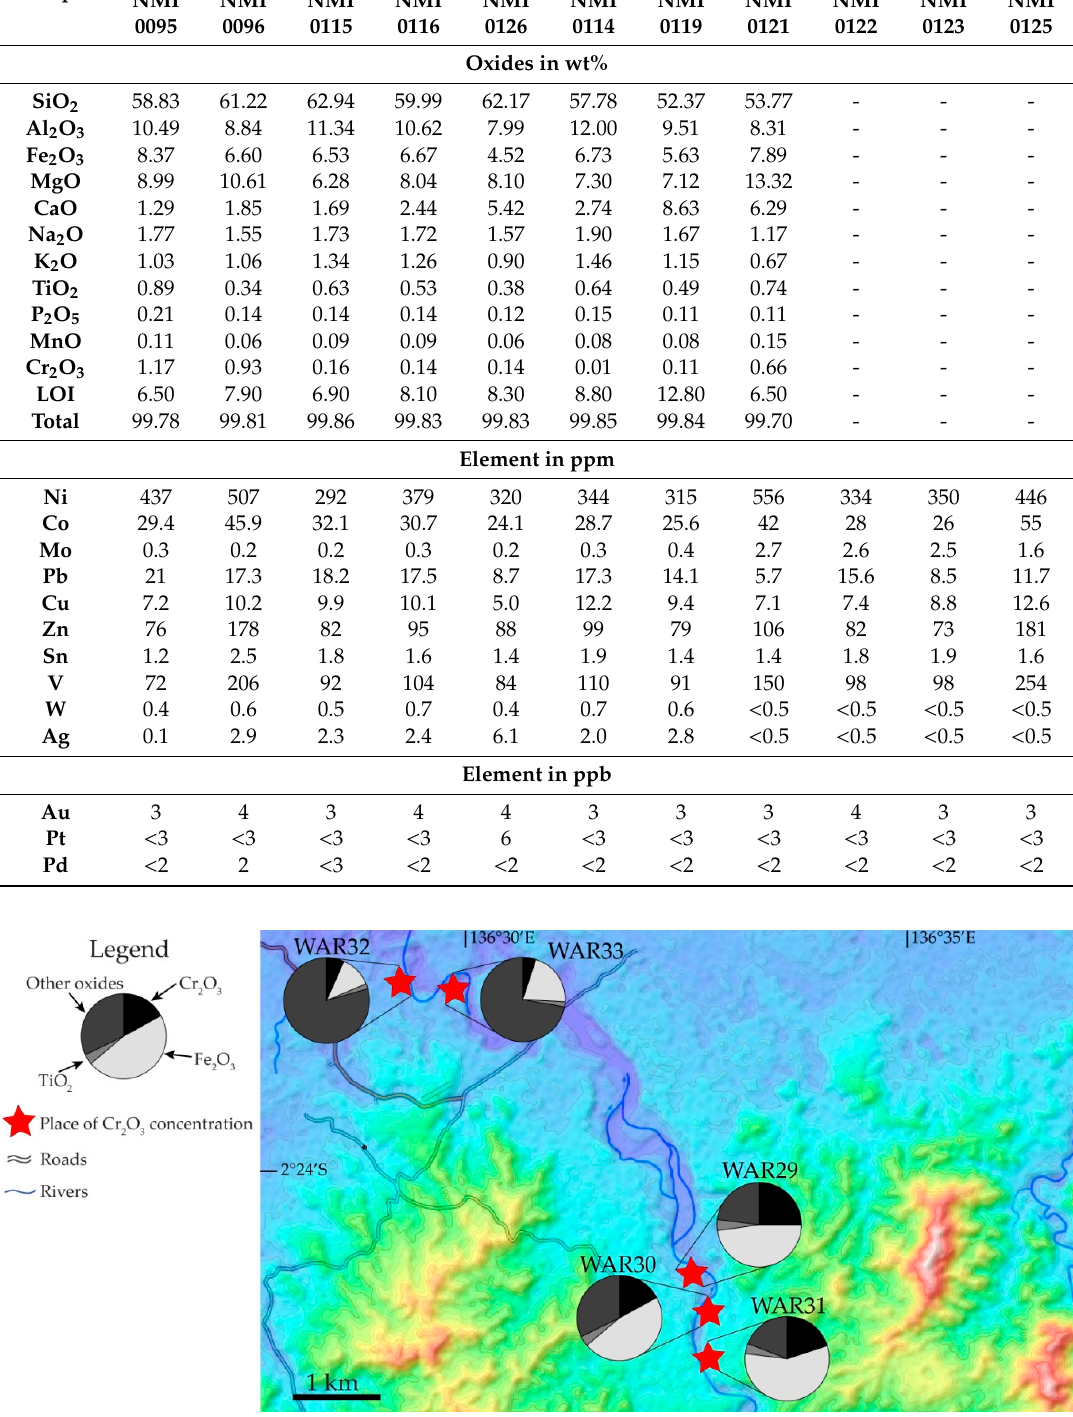
Table 4. Chemical composition of heavy minerals concentrate from the Botawa River. ICP-MS (Inductively coupled plasma mass spectrometry) analysis. Sample